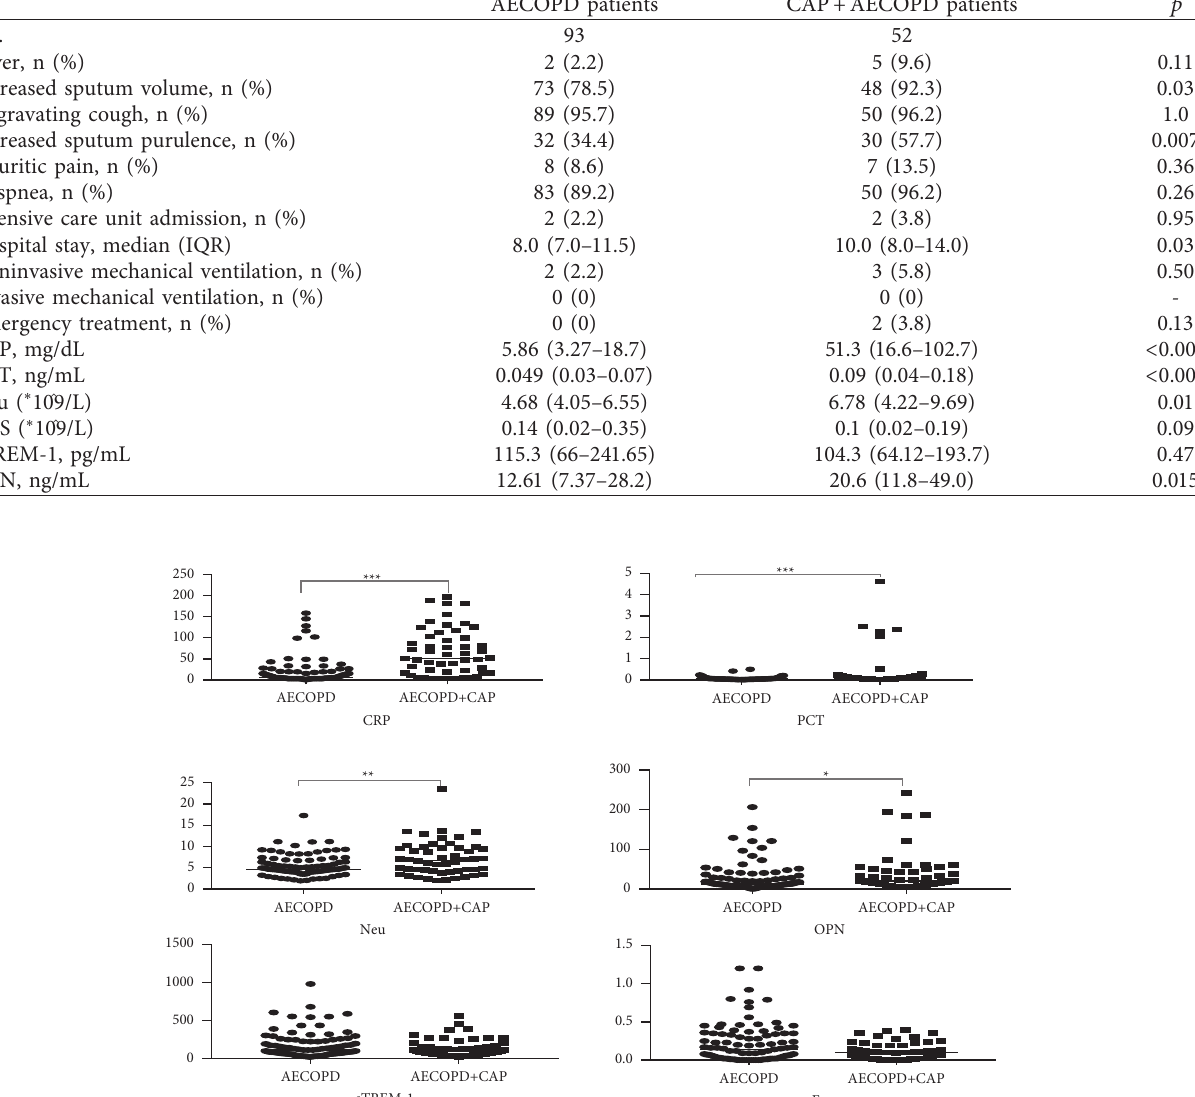
Figure 1: The levels of CRP, PCT, Neu, OPN, sTREM-1, and EOS in patients with AECOPD and AECOPD+CAP. Note: ∗ p < 0 . 05; ∗∗ p < 0 . 01; ∗∗∗ p < 0 .